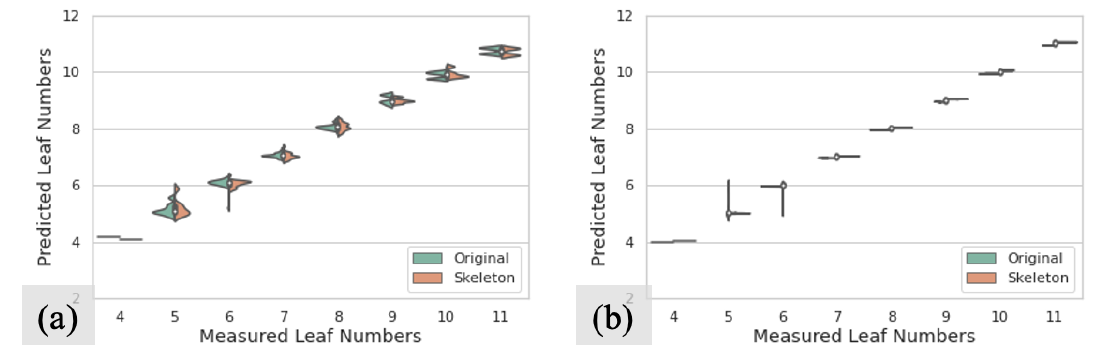
Figure 8. The distributions of predicted leaf numbers in testing datasets without occlusion: ( a ) pre- diction distributions in S1 datasets without augmentation; ( b ) prediction distributions in S1 datasets with six transformations. In each plot, green parts represent the results from the original images, and orange parts represent the results from skeleton images.